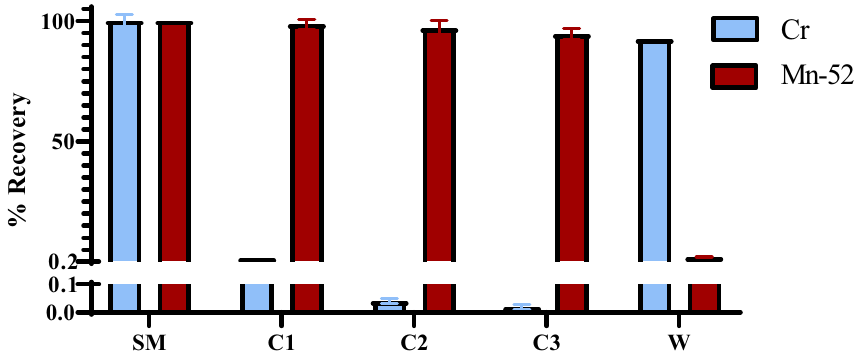
Figure 5. ICP-MS and HPGe data of radioactive purifications of 52 Mn using the three-column semi-automated system. The results are expressed in Average ± SD; N = 3. SM Starting Material, C1 Column 1, C2 Column 2, C3 Column 3, W Waste